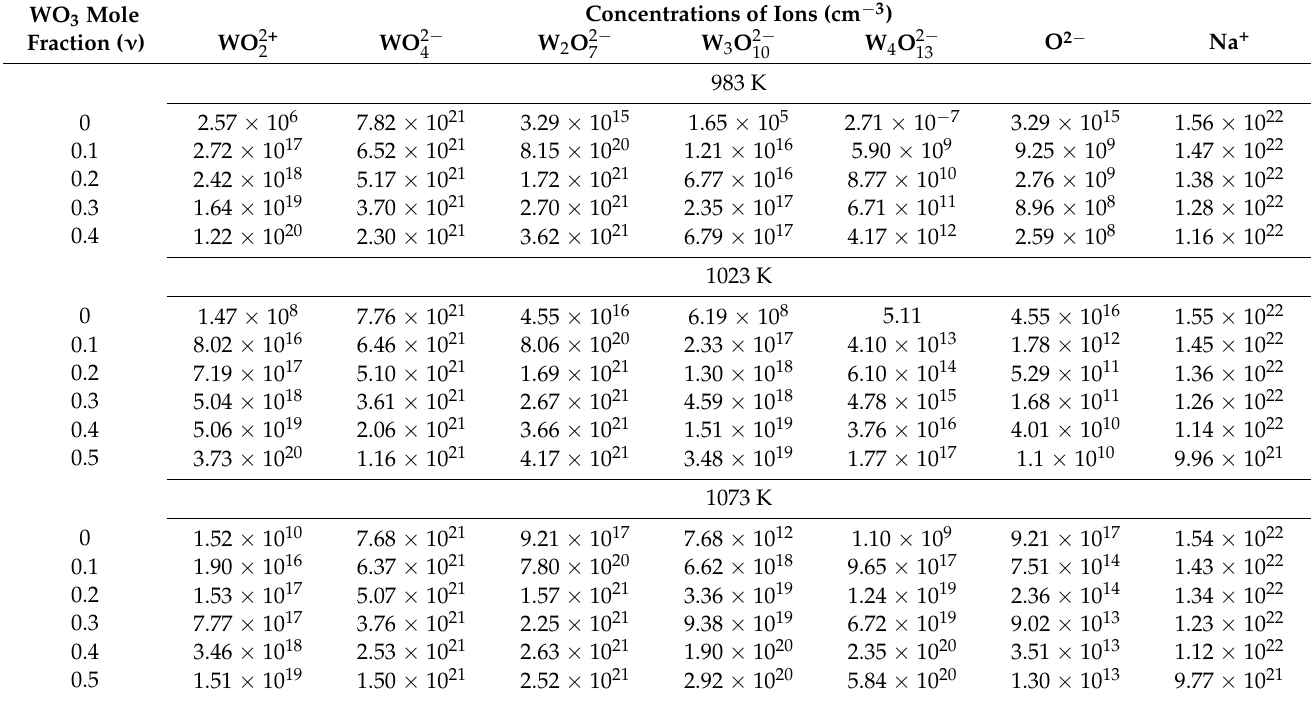
Table 2. Calculated values of ionic concentrations in Na 2 WO 4 –WO 3